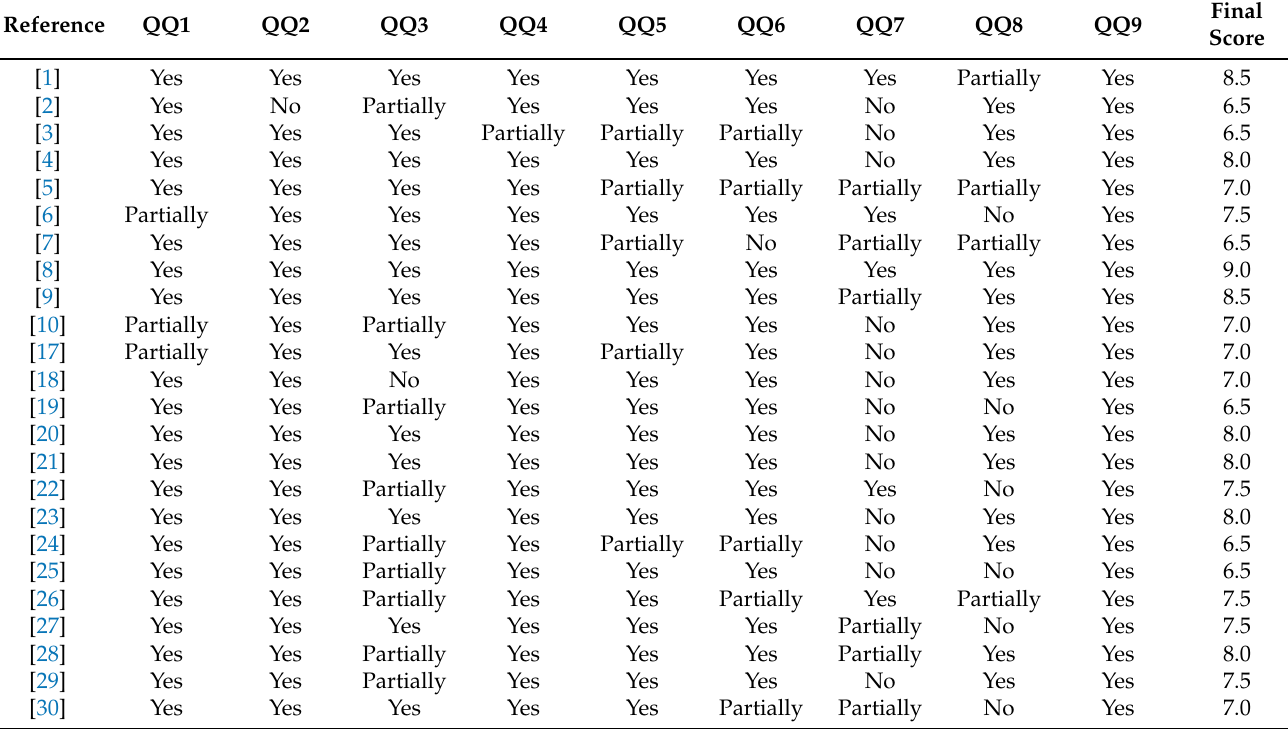
Table 2. Results of quality